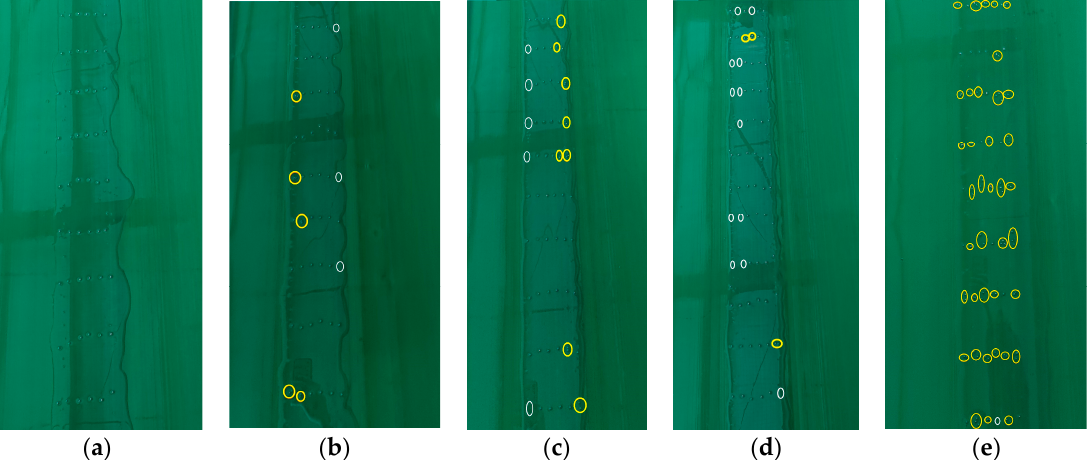
Figure 11. Seed distribution on oiled belt: ( a ) θ = 0°, ( b ) tilting to − X direction at θ = 6°, ( c ) tilting to X direction at θ = 6°, ( d ) tilting to − Y direction at θ = 6°, and ( e ) tilting to Y direction at θ = 6°. Note that circles in white and yellow represent missing seeds and ≥ 2 seeds per ridge, respectively.